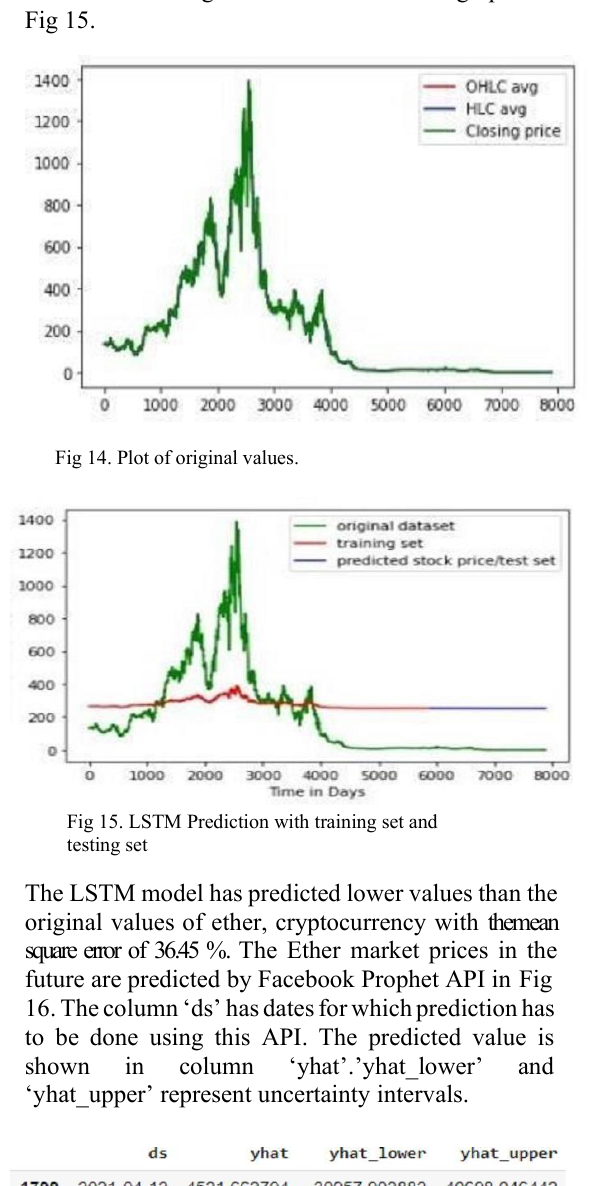
Fig 11. Skewness transformation of the VALUES in Ethereum dataset.